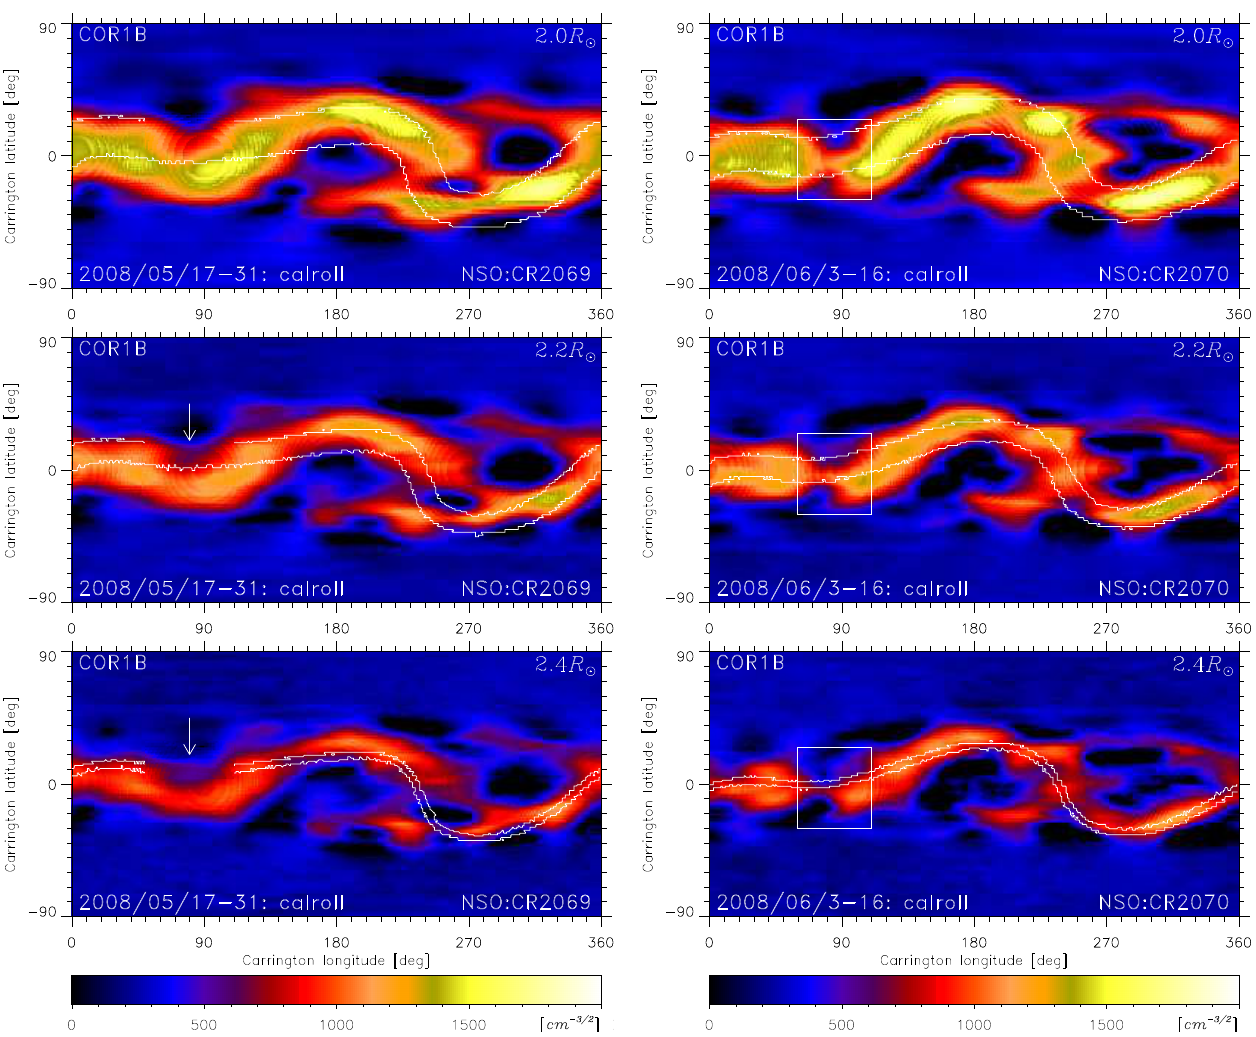
Fig. 1. Spherical cross-section of the reconstructed electron density in square root scale at heliocentric distances 2 . 0 , 2 . 2 and 2 . 4 R ⊙ (the distances are shown in the right upper corners). The reconstruction for the period before the CME of June 1st, 2008 is shown on the left panel while the reconstruction for the period after this CME is shown on the right panel. The white lines are the boundaries between closed and open magnetic field lines for PFSS model with source surface at 2 . 5 R ⊙ corresponded for CR 2069 and CR 2070, i.e. periods approximately before and after the CME. The part of the lines on the left panel between Carrington longitudes 50 and 110 ◦ are not shown in order to more clearly show the connecting structure in this region (marked with arrow). However the lines in this region are almost horizontal.